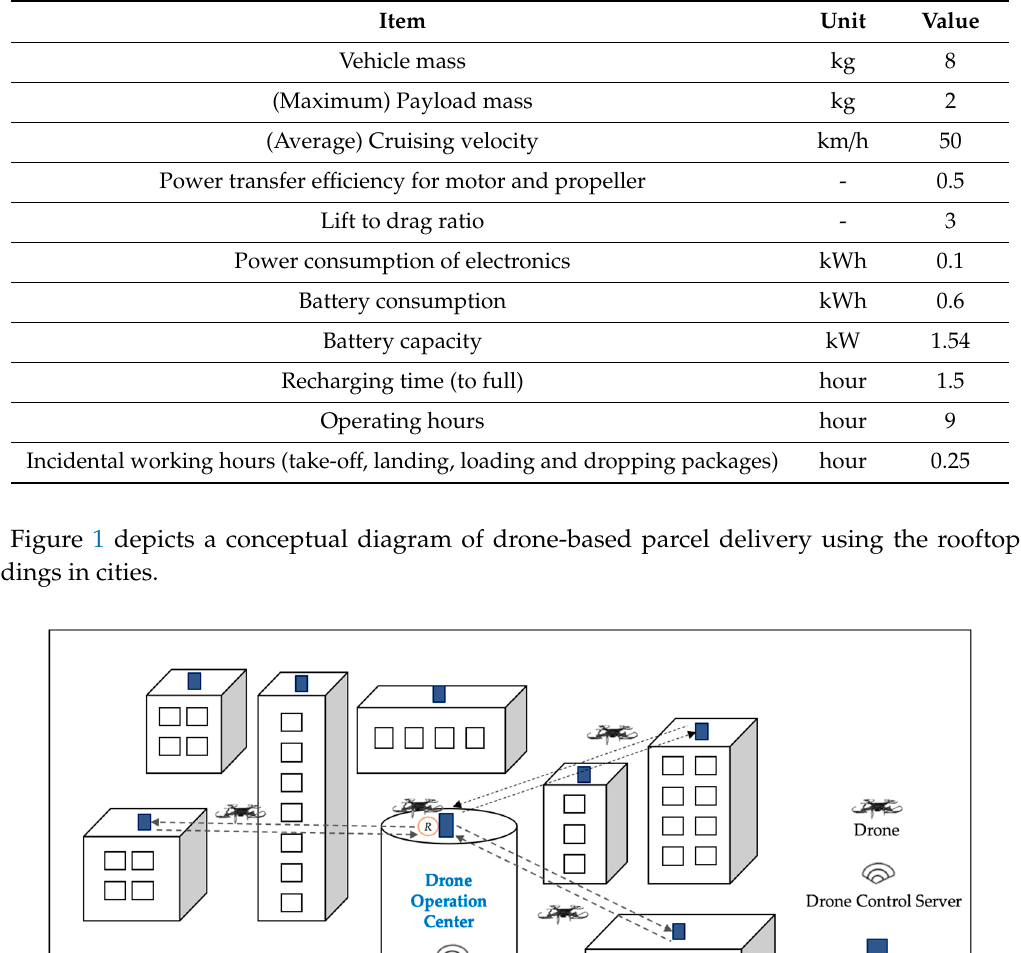
Table 1. Delivery drone specifications in the case study.